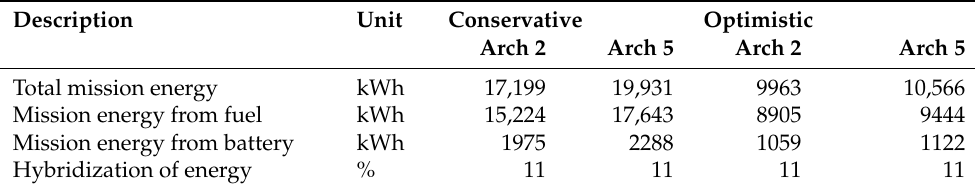
Table 11. Results on energy from the initial sizing for Architectures 2 and 5.